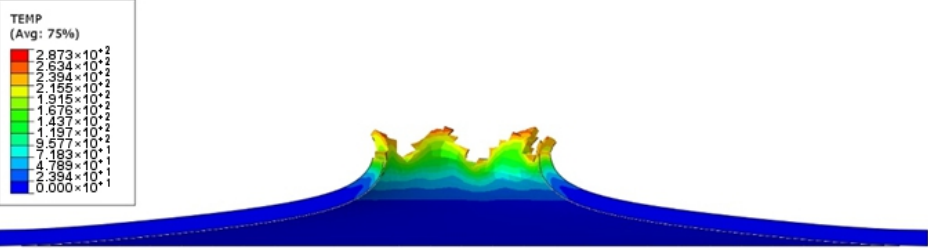
Figure 19. PEEQ strain visualization during the puncture of a sheet made of titanium alloy. Figure 20. Temperature increase visualization due to the puncture of the titanium alloy sheet by the striker—section view.